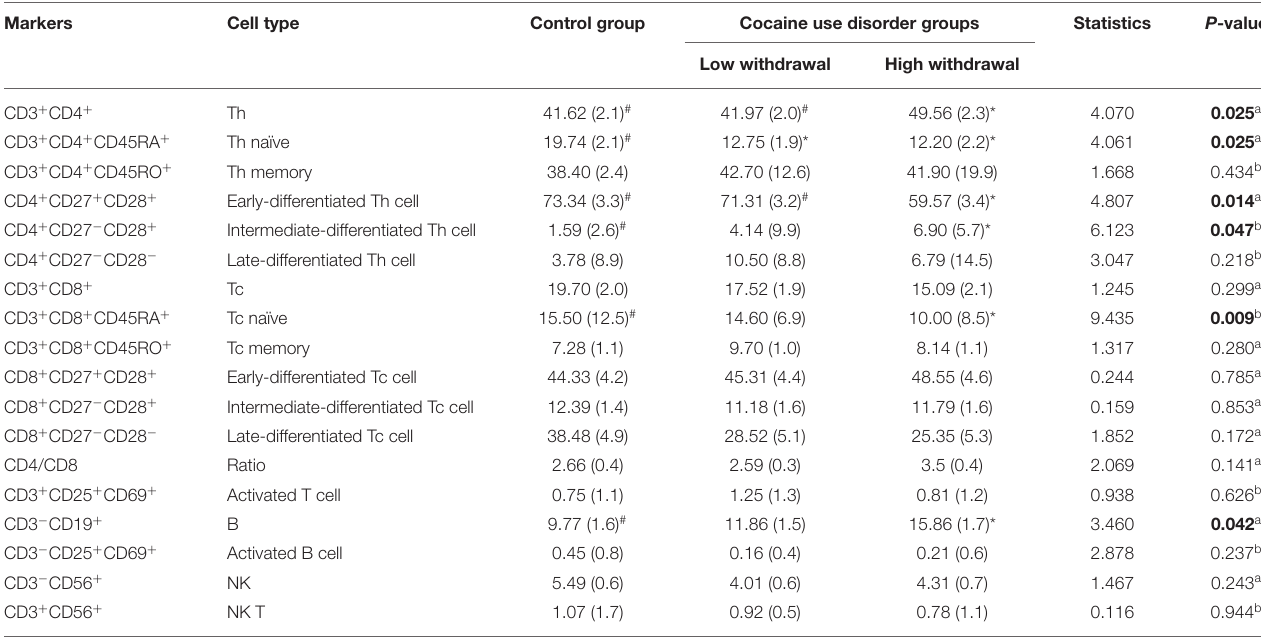
TABLE 2 | Immunophenotyping of lymphocyte subsets.